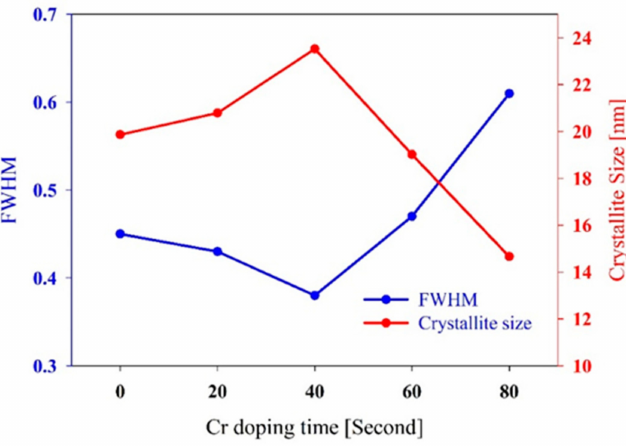
Figure 3. Effect of doping time on the FWHM and crystallite size.